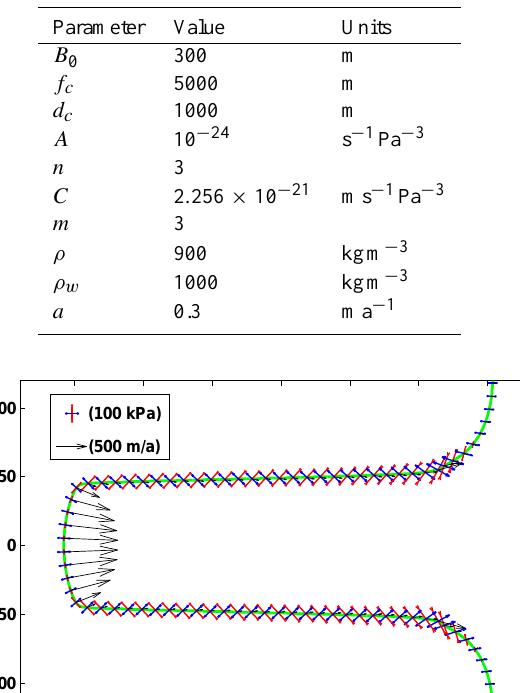
Table 1. Model parameters. The parameters B 0 , f c and d are geo- metrical parameters that affect the shape of the bedrock (see Eqs. 22 to 24). A and n are the rate factor and the stress exponent of Glen’s flow law, respectively, C and m are the basal slipperiness and the stress exponent of Weertman’s sliding law, and ρ and ρ w are the specific densities of ice and ocean. The variable a is the surface mass balance in the units of ice equivalent. The number of days in a year is 365.25.